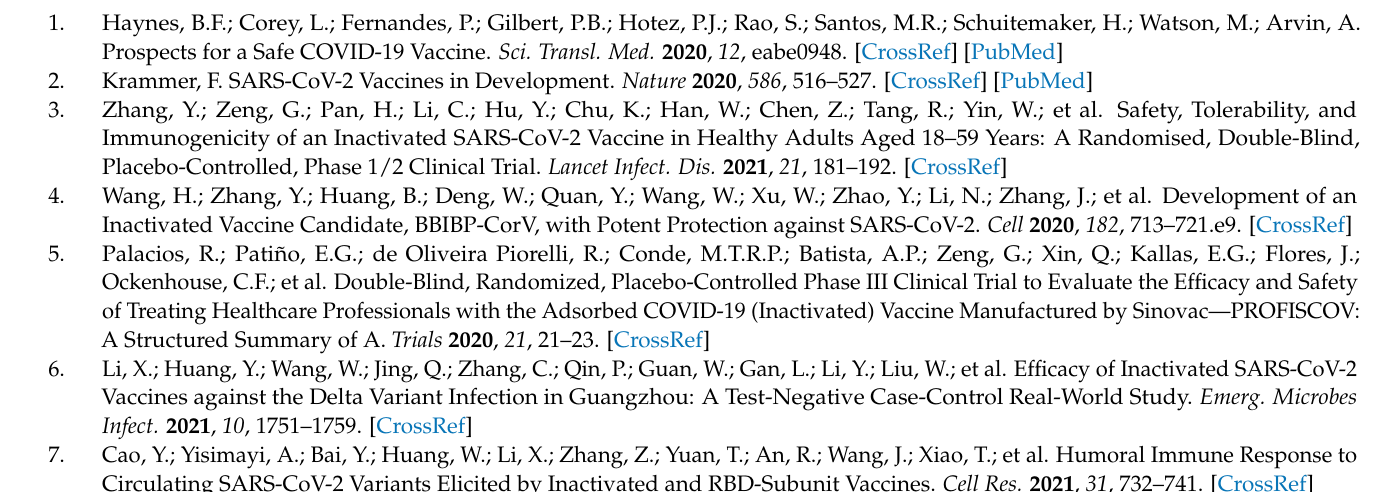
Figure S6: Differentially expressed genes in T cells; Figure S7: Differentially expressed genes in CD4+ T cells; Figure S8: Differentially expressed genes in CD8+ T cells; Figure S9: Differentially expressed genes in NK cells; Figure S10: Differentially expressed genes in myeloid cells; Figure S11: Enrichment GO (left panels) and KEGG (right panels) analyses for B cells; Figure S12: Enrichment GO (left panels) and KEGG (right panels) analyses for T cells; Figure S13: Enrichment GO (left panels) and KEGG (right panels) analyses for CD4+ T cells; Figure S14: Enrichment GO (left panels) and KEGG (right panels) analyses for CD8+ T cells; Figure S15: Enrichment GO (left panels) and KEGG (right panels) analyses for NK cells; Figure S16: Enrichment GO (left panels) and KEGG (right panels) analyses for myeloid